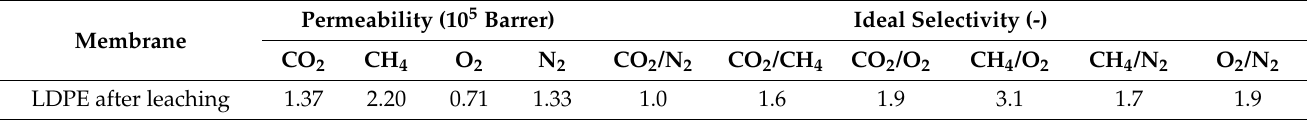
Table 6. Gas permeation results (CO 2 , CH 4 , O 2 , and N 2 ) of the